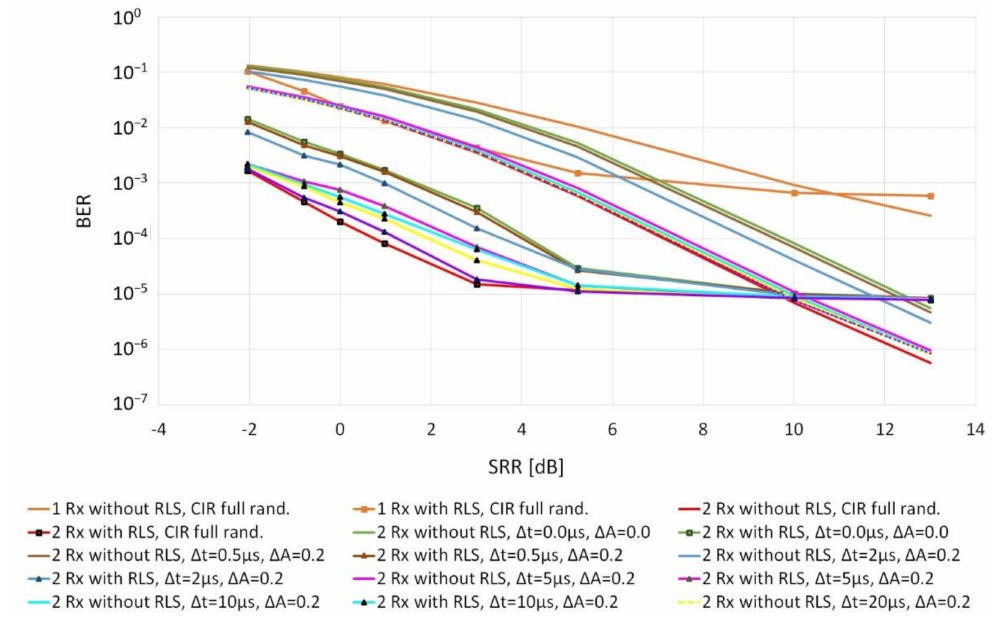
Figure 9. Impact of the di ff erentiation of impulse responses on the quality of diversity combining when using two receivers for SNR = 10 dB and 4 replicas.